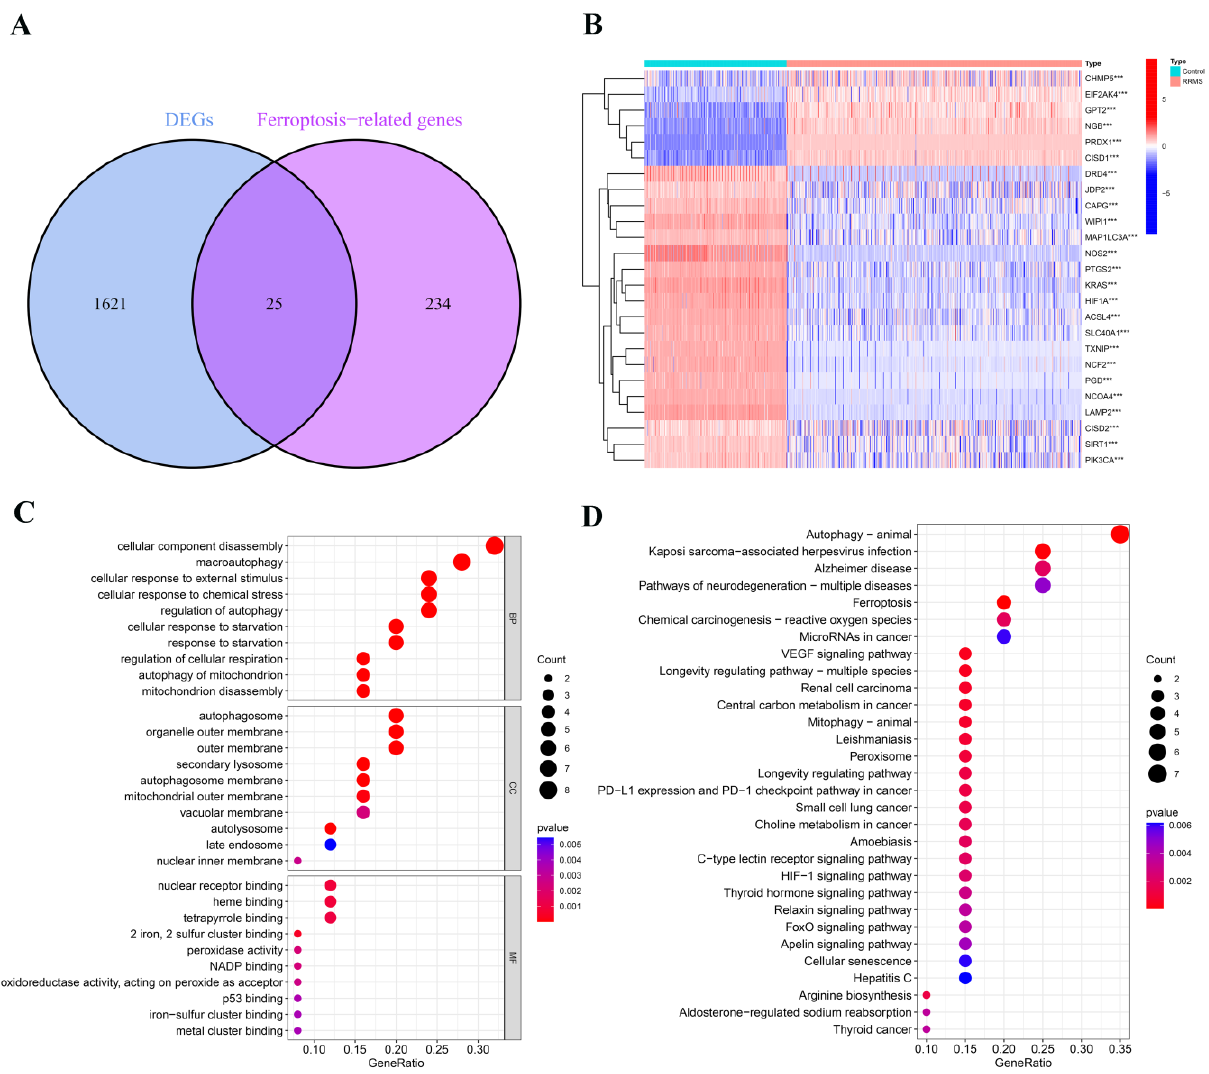
Figure 2. Identification and analysis of dysregulated differentially expressed ferroptosis-related genes (DE-FRGs) in RRMS. ( A ) Venn diagram of DE-FRGs. DEGs, differentially expressed genes. ( B ) The expression patterns of 25 DE-FRGs shown by heatmap. *** p < 0.001. ( C ) The bubble plot of GO terms enrichment results. ( D ) The bubble plot of KEGG pathway analysis results.